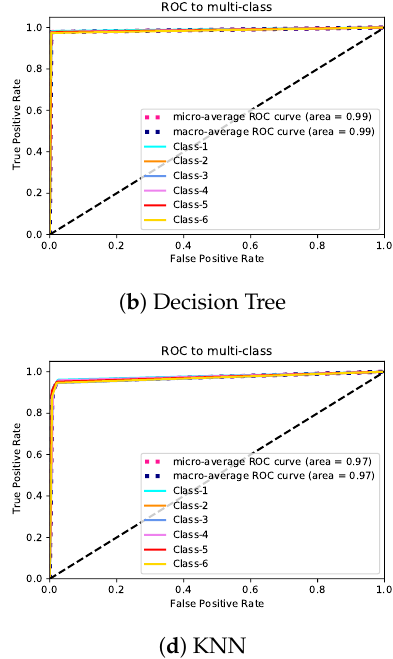
Figure 11. AUC-ROC curves for